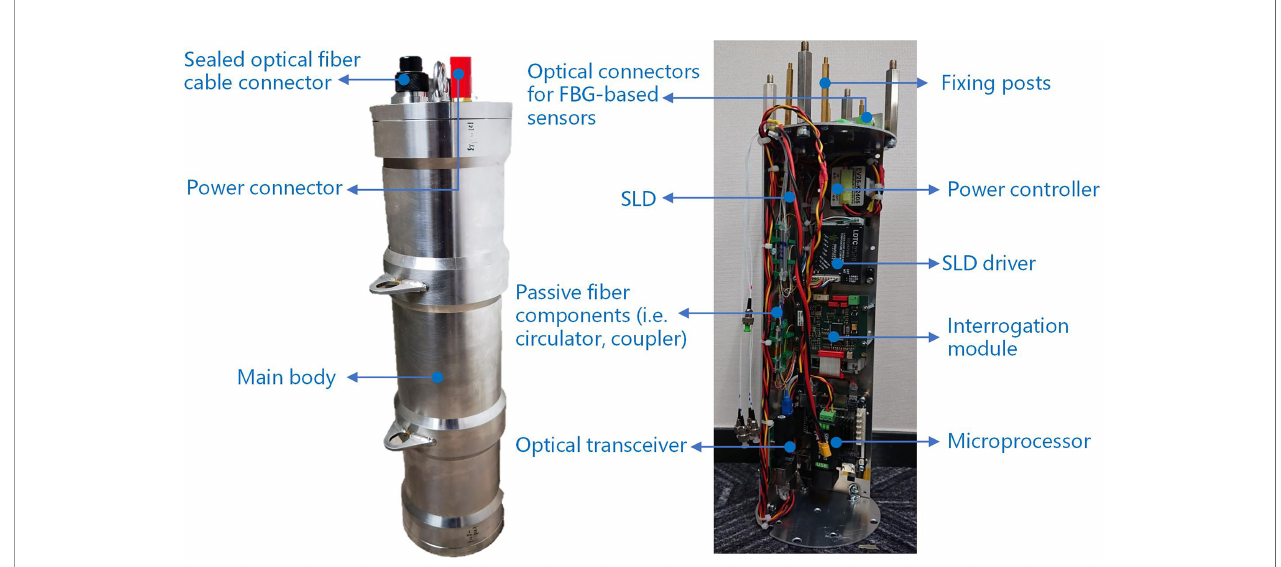
FIGURE 3 | Captured image of the prototype of the developed submarine interrogation